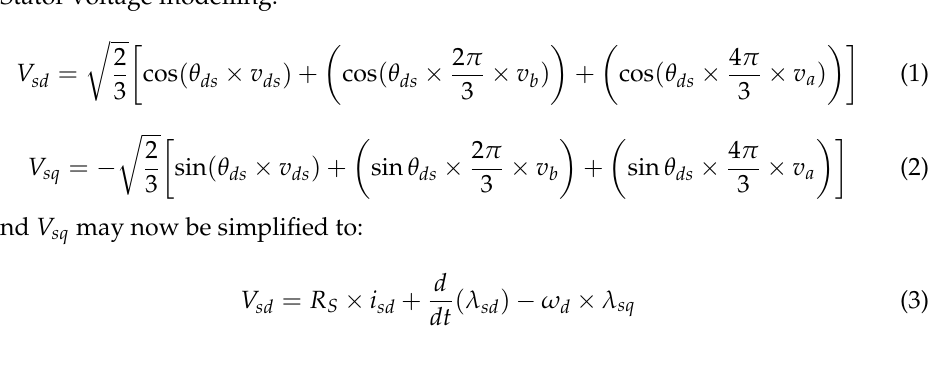
Figure 7. ( a ) The d-axis equivalent circuit of an induction motor. ( b ) The q-axis equivalent circuit of an induction motor.